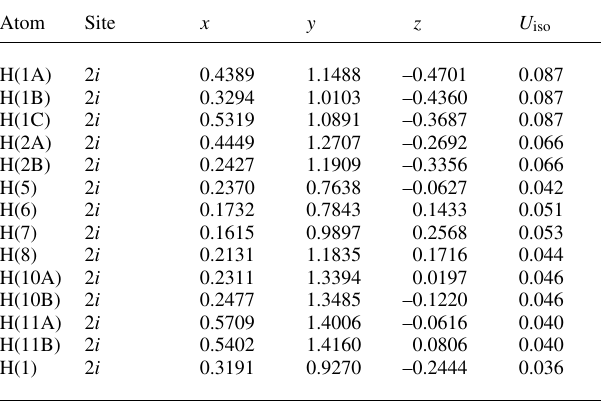
Table 2. Atomic coordinates and displacement parameters (in Å 2 )